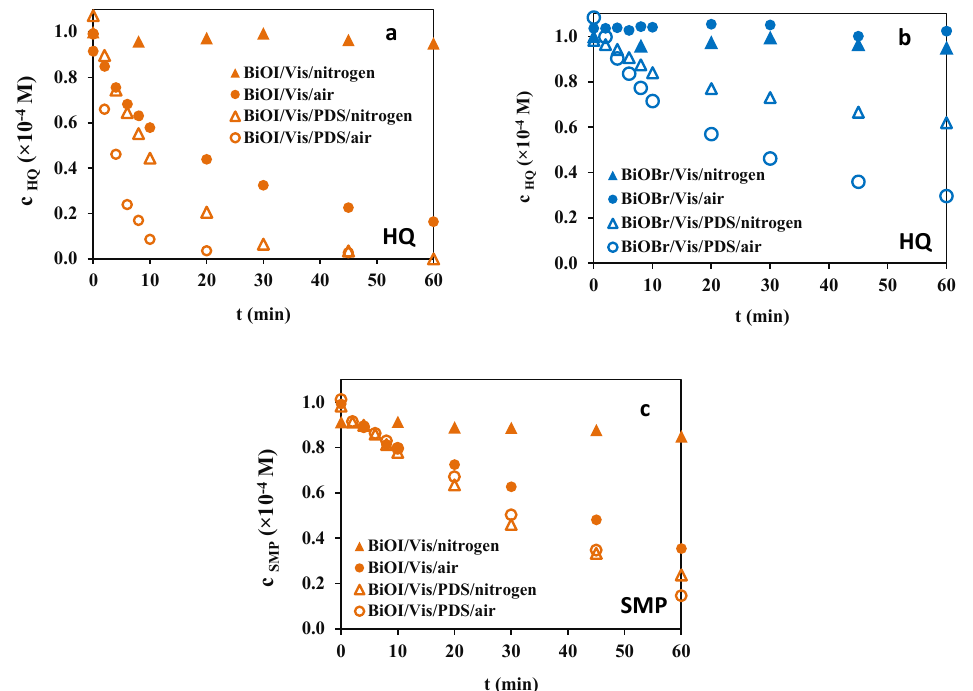
Figure 8. The Effect of dissolved O 2 on the transformation of HQ ( a , b ) and SMP ( c ). While the conversion rates of BQ and SMP in O 2 -free suspensions without PDS were negligible, the degradation proceeded efficiently in the presence of PDS (Figure 8). A sig- nificant difference is that in the case of HQ, the positive effect of dissolved O 2 is well man- ifested even in the presence of PDS. In contrast, for SMP, the transformation rate is not